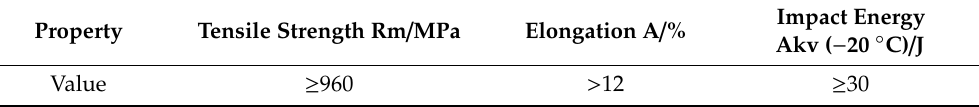
Table 2. Mechanical properties of Q960 high strength steel.